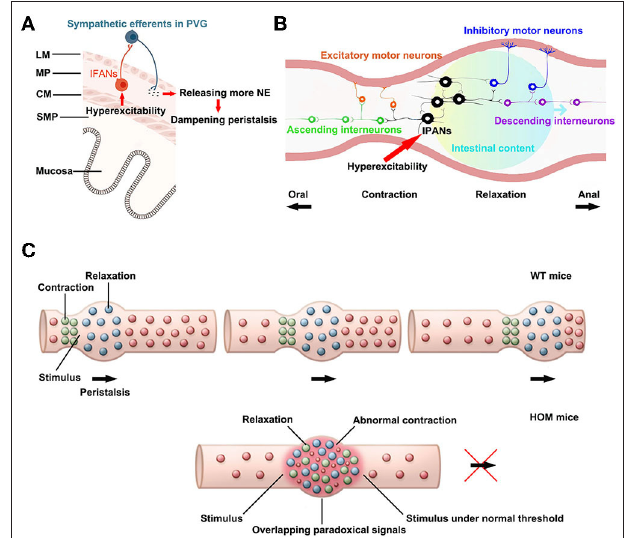
FIGURE 5 | The potential mechanisms for hyperexcitability in sensory afferents lead to reduced intestinal motility. (A) The influence on entero-enteric inhibitory reflexes. PVG: prevertebral ganglion, IFANs: intestinofugal afferent neurons, NE: noradrenaline, LM: longitudinal smooth muscle, MP: myenteric plexus, CM: circular smooth muscle, SMP: submucosal plexus. The paragraph was modified from Spencer and Hu ( 26). (B) The alteration in peristalsis reflexes. IPANs: intrinsic primary afferent neurons. This paragraph was modified from Fung and Vanden Berghe (32). (C) The abnormal peristalsis reflexes triggered by hyperexcitability sensory neurons might disrupt intestinal peristalsis waves. WT, wild-type ( Scn11a + / + mice); HOM, homozygote ( Scn11a R222S / R222S mice). This paragraph was modified from Mawe